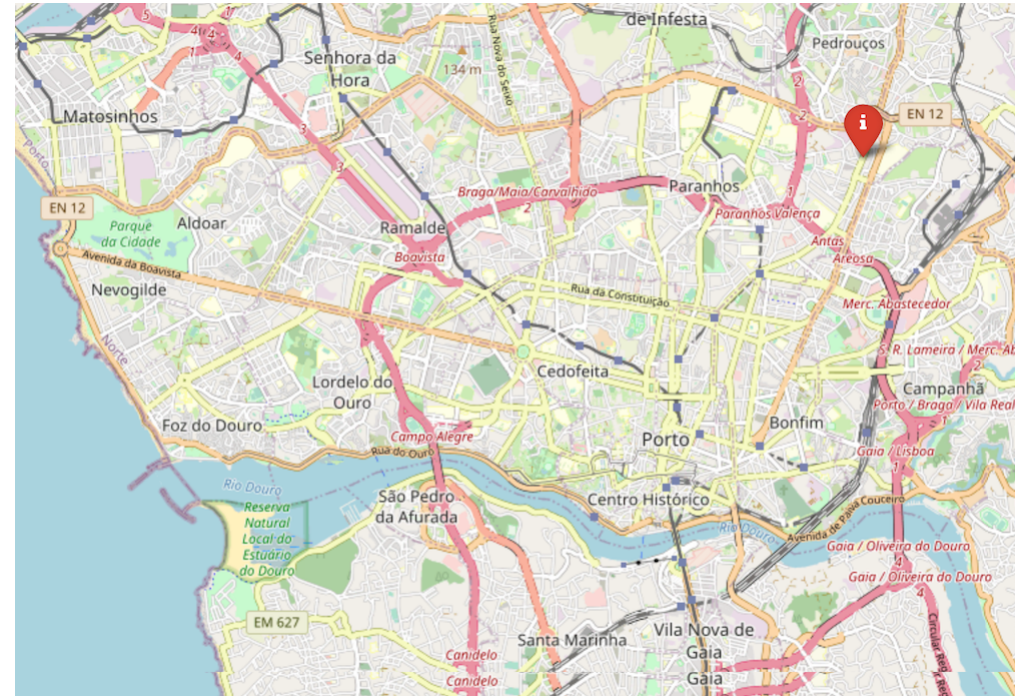
Figure 10. One alarm is being generated when fire and noise are being detected.